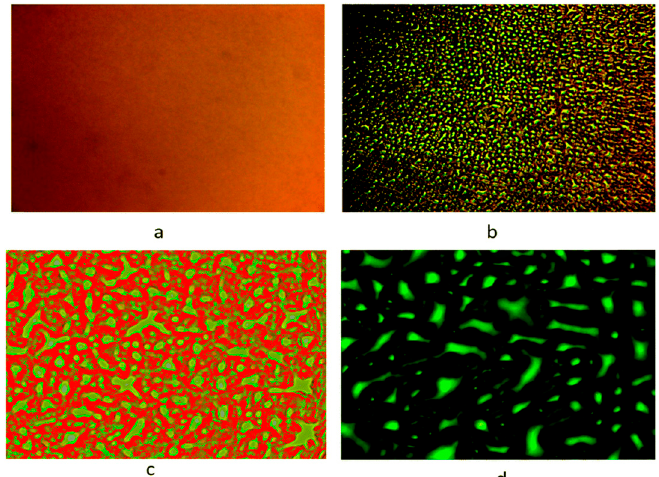
Figure 2. Optical micrographs of epoxy system modified with 16.6 wt % of methacrylate acrylonitrile butadiene styrene (MABS): ( a ) homogenous morphology ( b ) development of droplets of epoxy phase at 400 s, ( c ) bicontinuous structure at 550 s, and ( d ) elongated structures of the epoxy at 800 s. Reprinted with permission from ref. [39], Copyright [2019], The Royal Society of Chemistry.